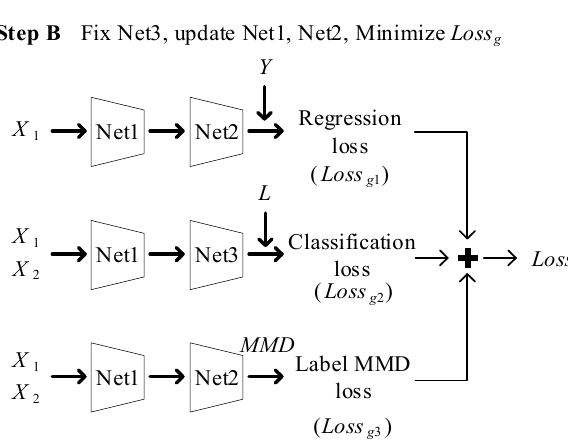
Figure 2. Diagram of network training steps.